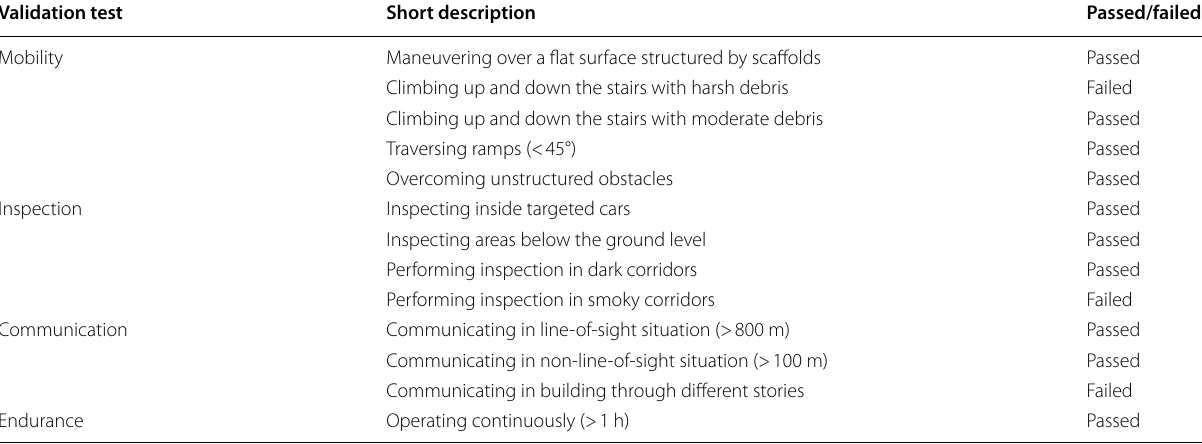
Table 4 Validation tests taken by the robot in the training field Validation